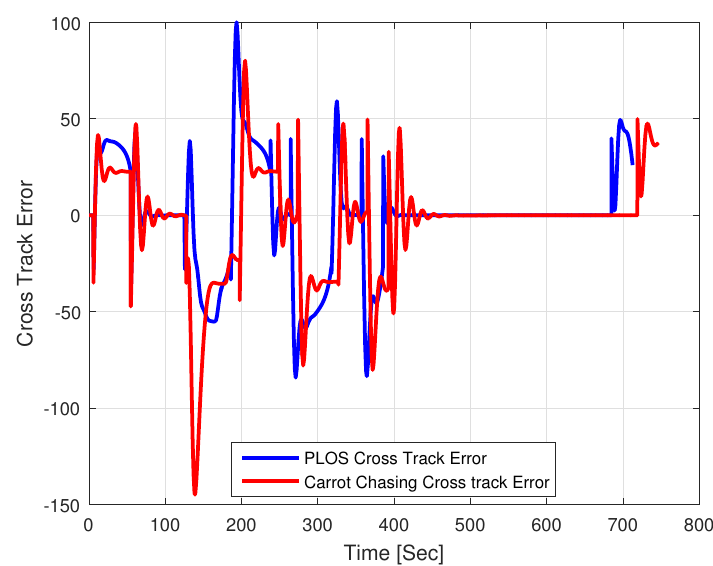
Figure 27. Cross track error associated with both path following methods with wind.